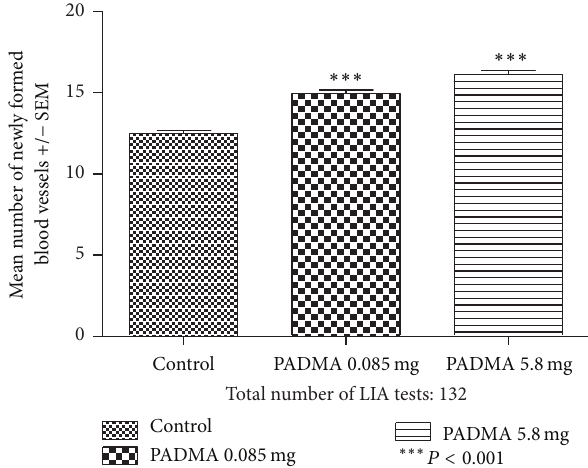
Figure 1: Effect of PADMA 28 (0.085 or 5.8 mg) supplementation of Balb/c donors on the number of newly formed blood vessels measured by lymphocyte-induced angiogenesis test (LIA) in F1 (Balb/c × C3H) recipient mice. Balb/cmicewere feddaily per os with 0.085 mg or 5.8mg of PADMA 28. After 7 days, mice were bled and sacrificed, and splenocytes were isolated. Splenocytes were pooled within the groups, resuspended in Parker culture medium (1 million of cells in 0.05mL), and injected intradermally (5-6 injections per mouse) to 24 F1 (Balb/c × C3H) hybrids. After 72 hours the mice were euthanized, and newly formed blood vessels were counted in dissection microscope (6x magnification). Results are shown as mean ± SEM. ∗∗∗ 𝑃 < 0.001